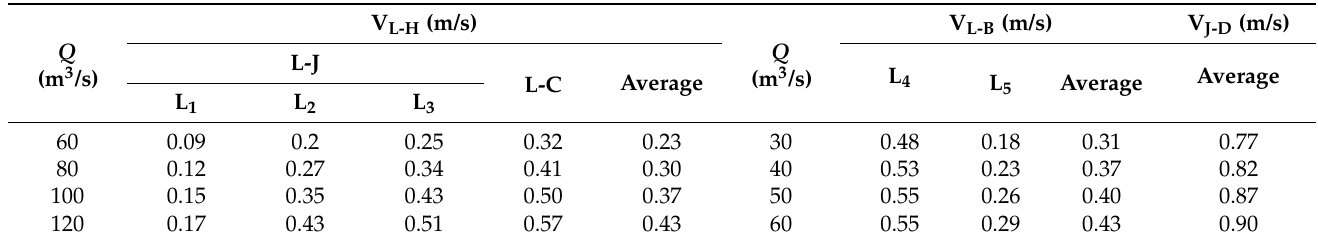
Table 2. Hydrodynamic simulation results of the main